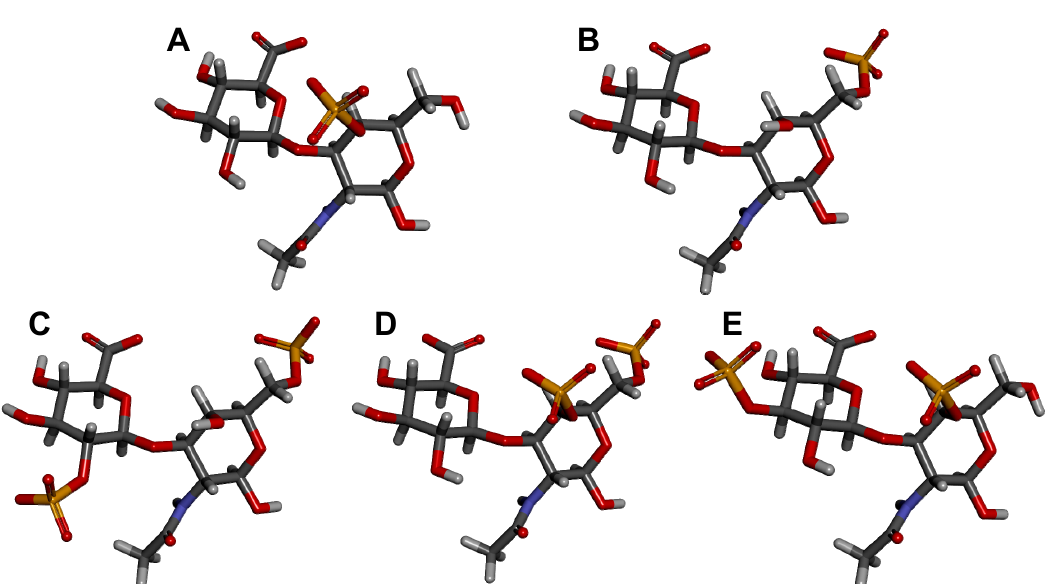
Figure 3. Representative disaccharide units of CS types, ( A ) CS-A, ( B ) CS-C, ( C ) CS-D, ( D ) CS-E, and ( E ) CS-K in their 3D stick models. Table 1 displays the structural description of these disaccharides. Hydrogens, carbons, oxygens and nitrogens are respectively represented in light grey, dark grey, red and blue. The carbon numbering and monosaccharide units are the same as shown in Figure 2, since all structures are the GlcA( β 1 − 3)GalNAc disaccharide backbone. Models created by the online AMBER/GLYCAM-based carbohydrate builder [40].